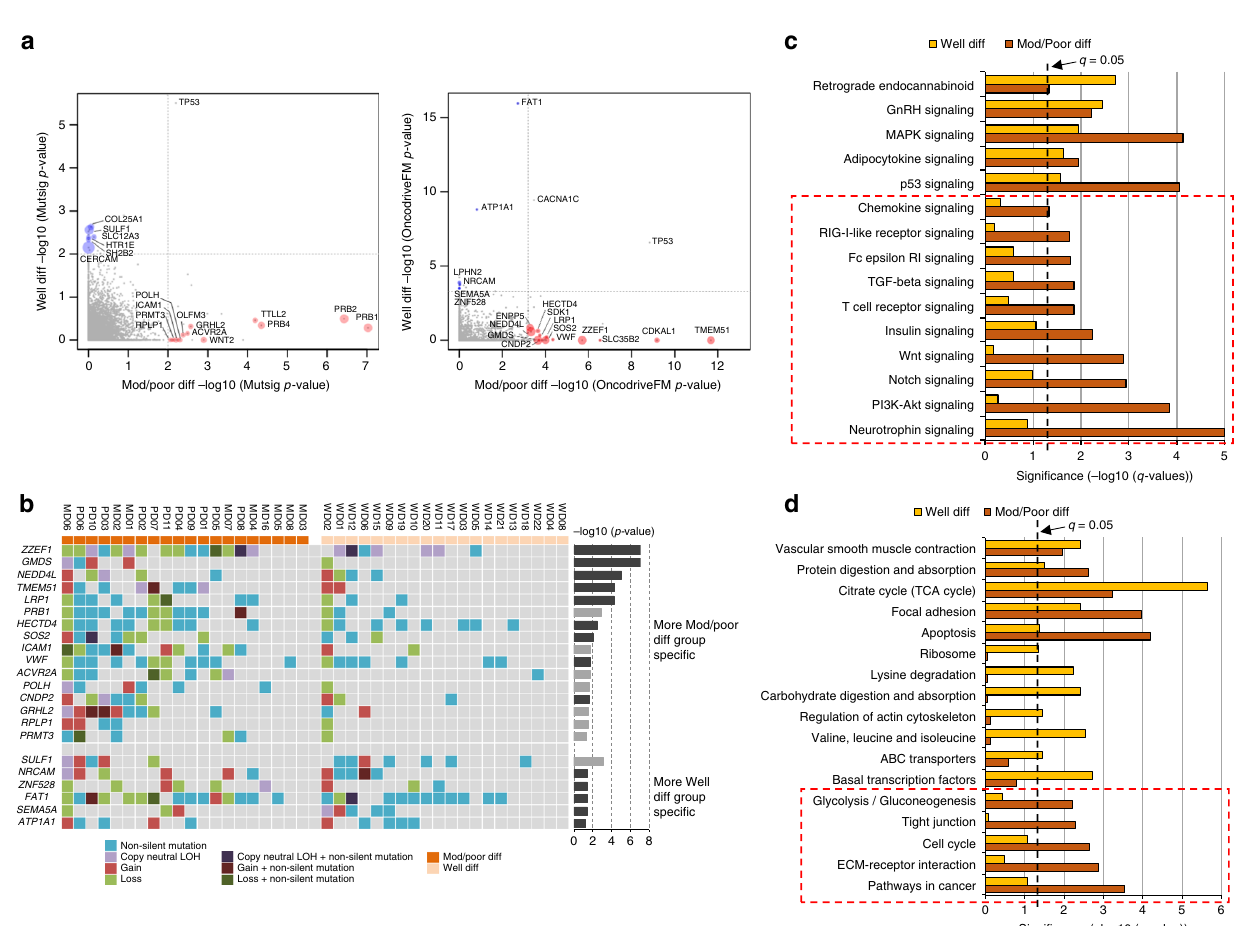
Fig. 7 Comparison of signi fi cantly mutated genes and pathways between moderate/poor and well-differentiated groups. a Group-speci fi c SMGs from the randomisation test based on MutSigCV and OncodriveFM p -values, respectively. Moderate/poor group-speci fi c genes were marked with red circles, while well-differentiated group-speci fi c genes were marked with blue circles. The size of the circle corresponds to its signi fi cance compared to that expected by chance. b Mutation OncoPrint of group-speci fi c genes that were expressed across 40 cSCC samples in moderate/poor and well-differentiated groups. Signi fi cance level (-log 10 ( p -value)) from the randomisation test was also shown for each gene as bar charts. Genes derived from the OncodriveFM statistics were shown in dark grey, while genes derived from MutSigCV statistics were in light grey. Genes at the top panel appeared to be more moderate/ poor group speci fi c, while genes at the bottom panel were more well-differentiated group speci fi c. c Signi fi cantly mutated KEGG signalling pathways and d biological processes between moderate/poor and well-differentiated groups. Signi fi cant pathways and processes in moderate/poor group only were marked with a dotted square. Pathways and biological processes in the bar charts were sorted with terms signi fi cant in both groups at the top, and terms signi fi cant in moderate/poor group only at the bottom (indicated with red dashed